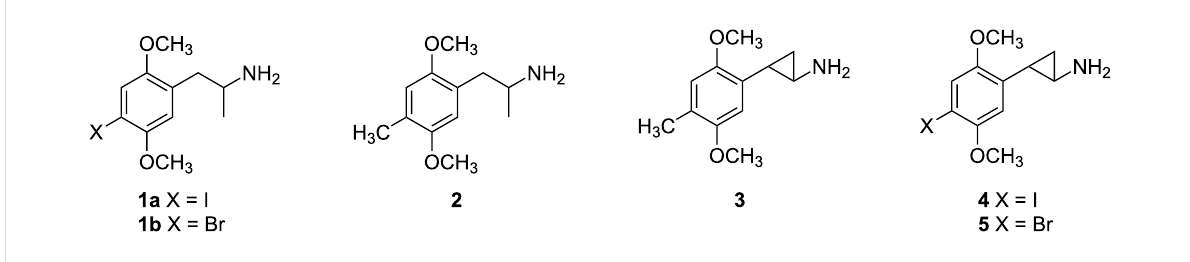
Figure 1: Structures of well-known serotonin 5-HT 2A agonists 1a,b , 2 , and 3 , and compounds 4 and 5 reported in this paper.